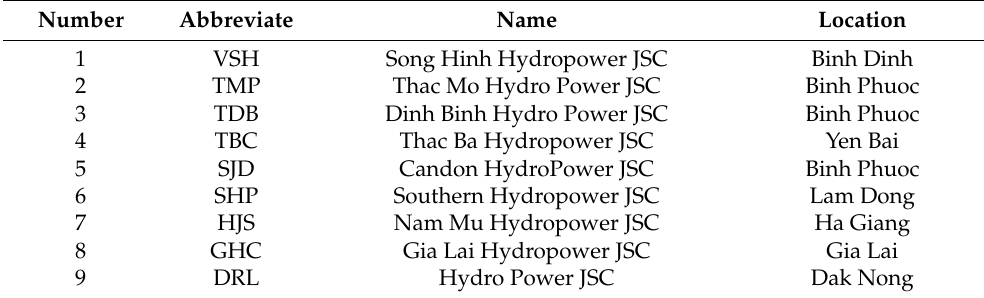
Table 1. Name of hydropower supplier in Vietnam.